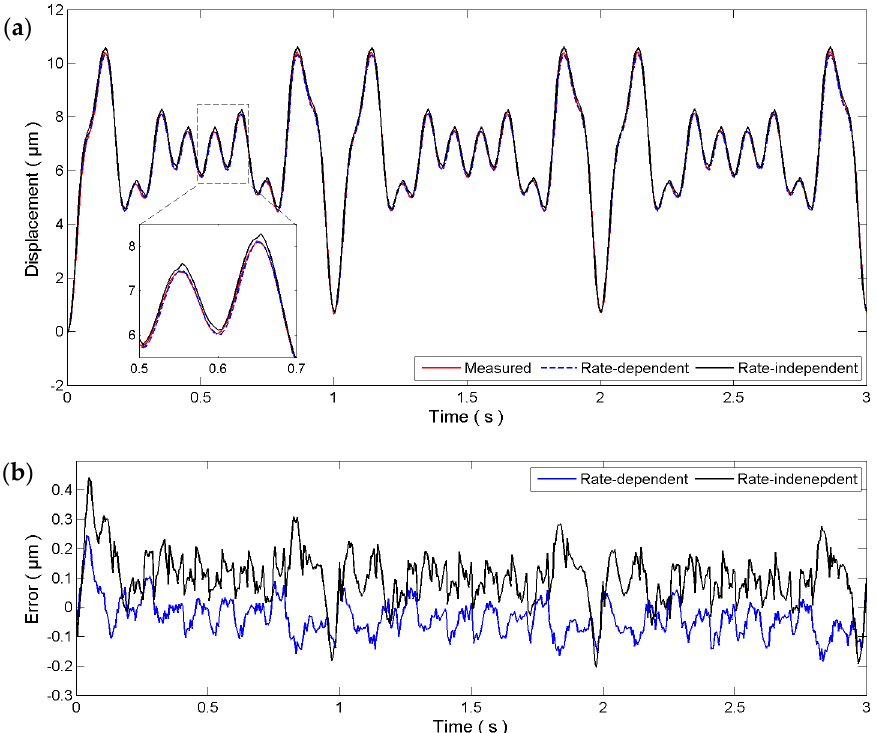
Figure 6. Verification of the identified hysteresis models using a superimposition of four sinusoidal signals: ( a ) time plot and ( b ) error plot.